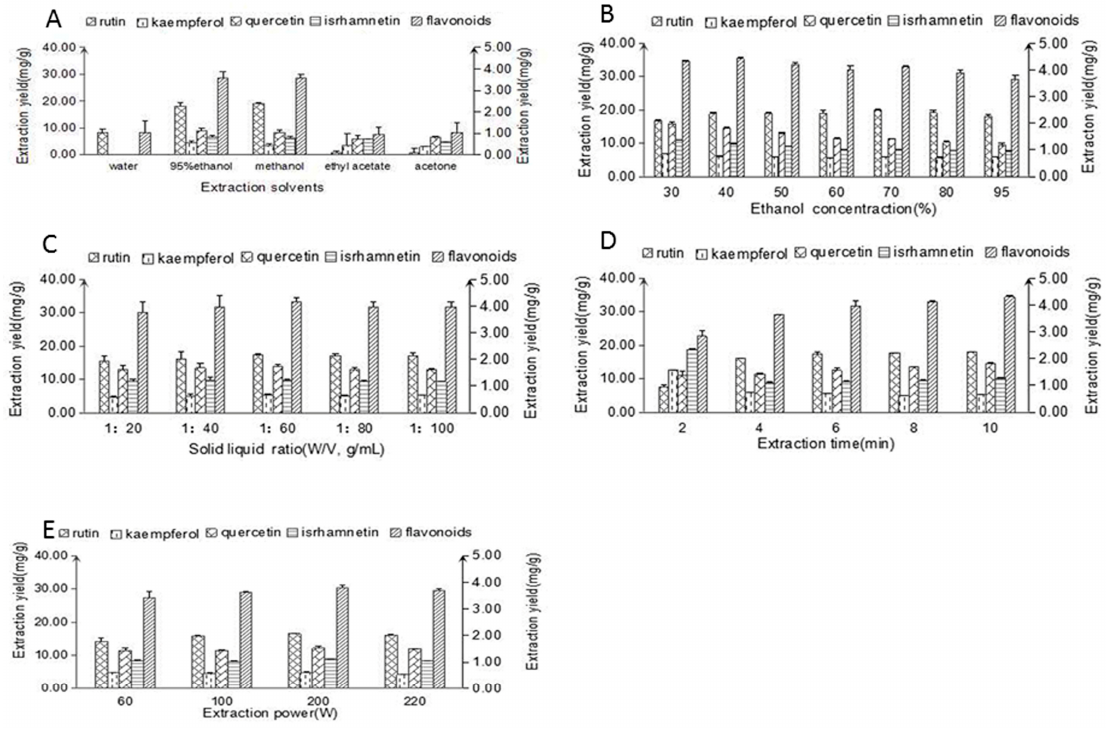
Figure 1. Effects of extraction solvents ( A ); ethanol concentrations ( B ); solid-liquid ratio ( C ); extraction time ( D ); and extraction powers ( E ) on the extraction yield of flavonoids (sum of the yield of rutin, quercetin, kaempferol, and isorhamnetin). Rutin, quercetin, and total flavonoids (left ordinate), kaempferol, isrhamnetin (right ordinate).